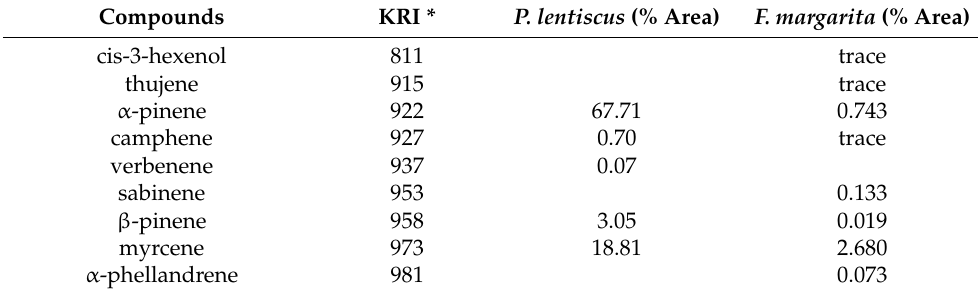
Table 1. Volatile compounds identified in P. lentiscus and F. margarita EOs by GC/MS analysis and their relative percent (%)